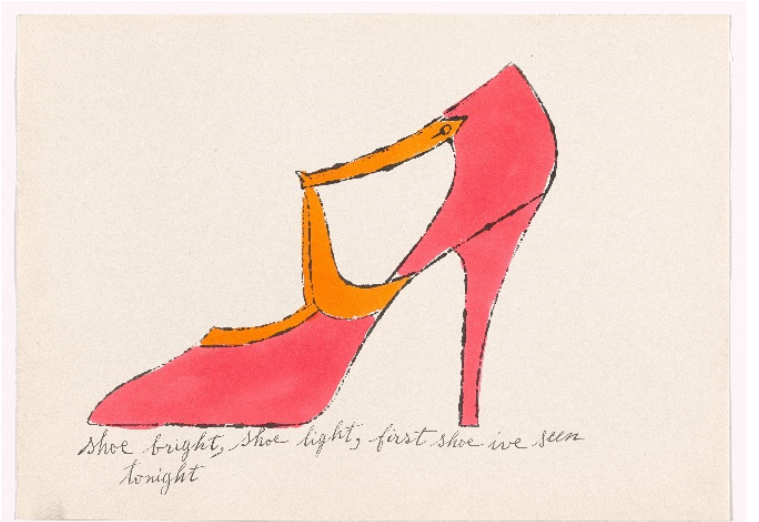
Figure 1. Andy Warhol Untitled from À la Recherche du Shoe Perdu , c. 1955. One from a portfolio of eighteen offset lithographs with synthetic dye-based ink additions. 9 ¾ × 13 11/16” (24.7 cm × 34.8 cm). The Museum of Modern Art. The Print Associates Fund. 2021 The remaining plates can be viewed online. © 2022 Andy Warhol Foundation for the Visual Arts/Artists Rights Society (ARS), New York, All reproductions of this work are excluded from the CC: BY License.